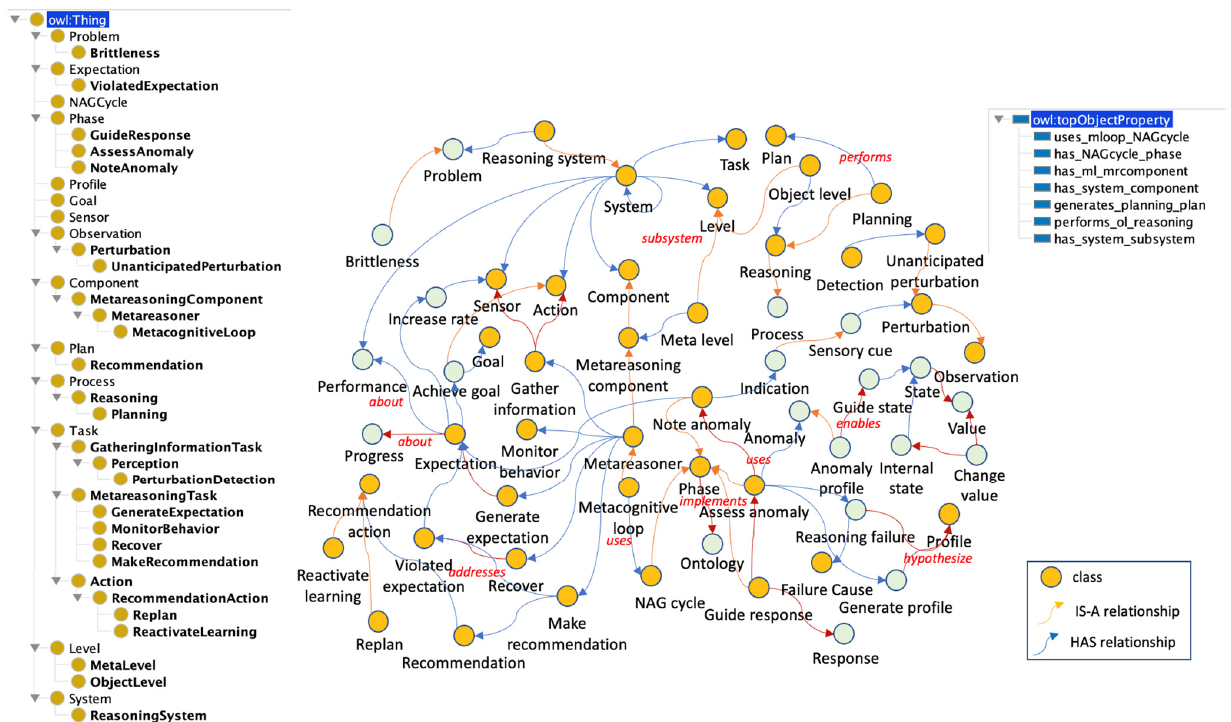
Figure 11. The DRFP subontology.